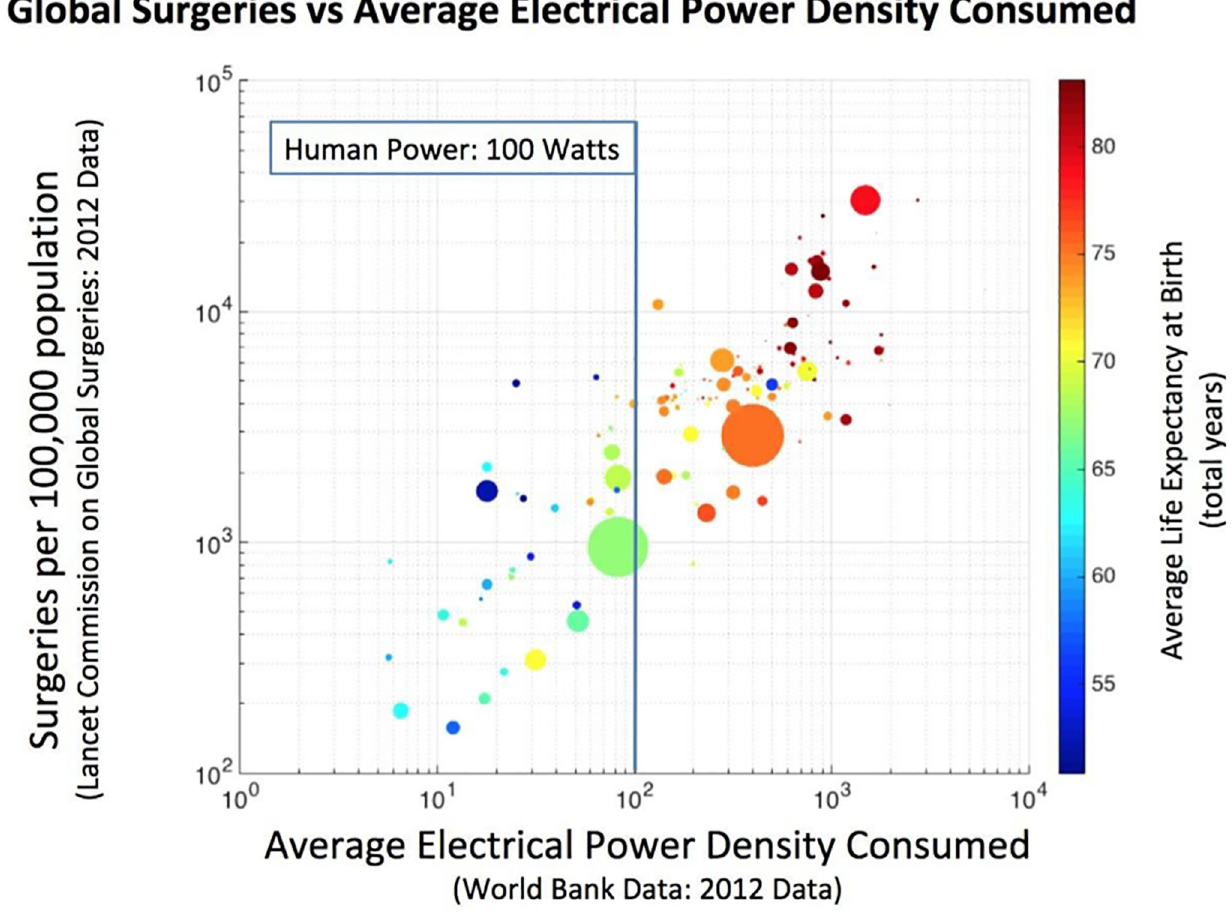
Fig 1. Global surgeries per 100,000 population is not equitably distributed around the world, dramatically interfering with average life expectancy at birth (colored data) plotted by country (size of circle is a country’s population). As global surgeries increase, average electrical power density consumed (2012 data on x-axis in units of Watts/Capita) must increase to ensure accessibility and reliability to health care facilities adding surgical wards.